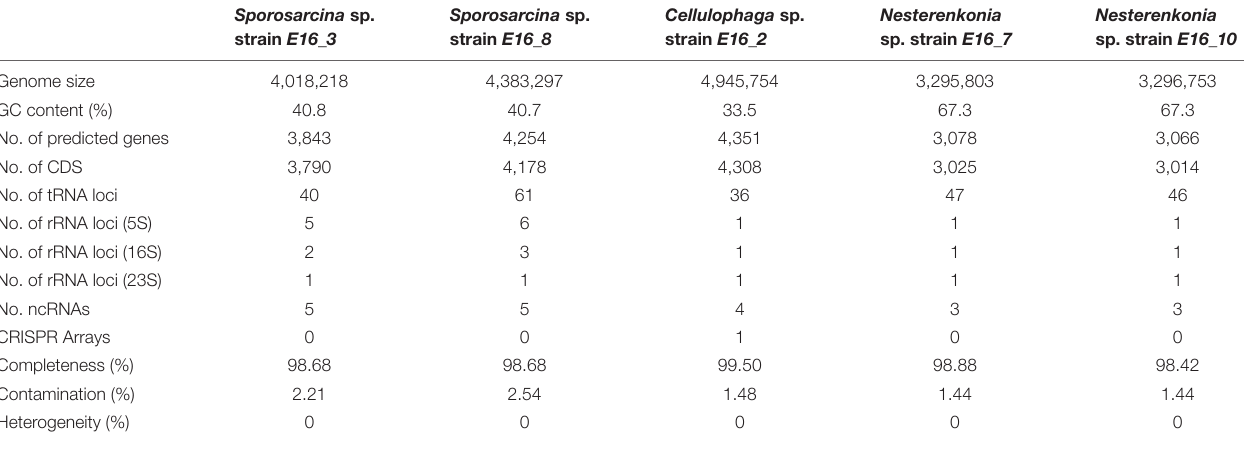
TABLE 1 | Summary of the genomic features of the Antarctic sponge-associated isolates. Sporosarcina sp. strain